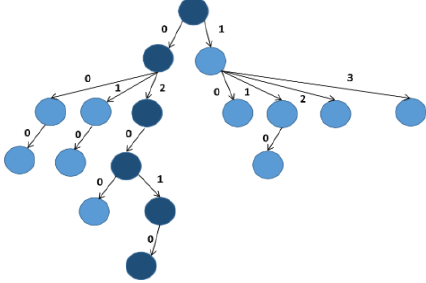
Figure 1. A path in a hypothetical state